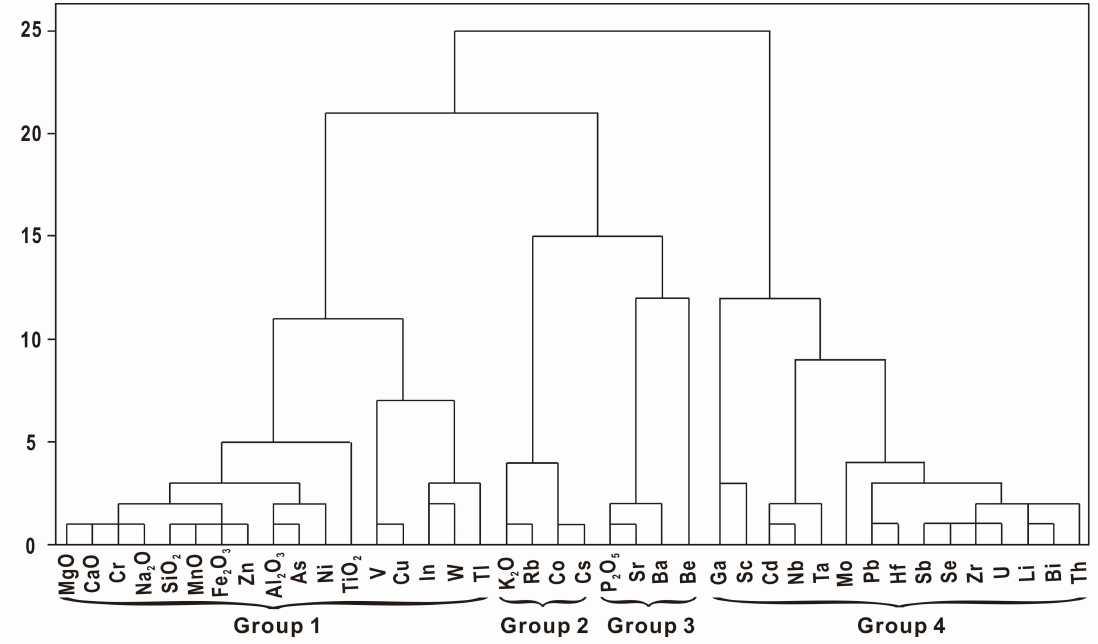
Figure 13. Hierarchical cluster analysis of elements in the Tashan